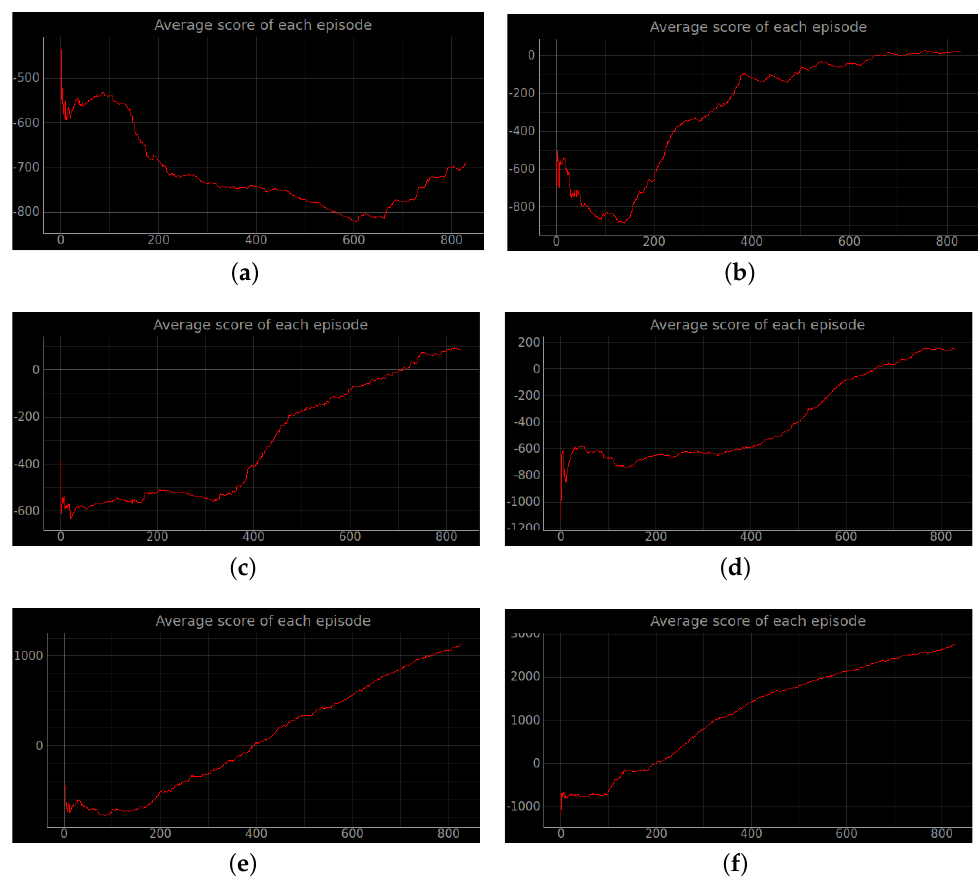
Figure 13. The curve of the cumulative sum of all rewards per turn for stage 4. The simulation results illustrate that the more challenging the environment is the higher the performance improvement of RND3QN compared to the DQN algorithm. ( a ) Original DQN; ( b ) Double DQN; ( c ) Dueling DQN;